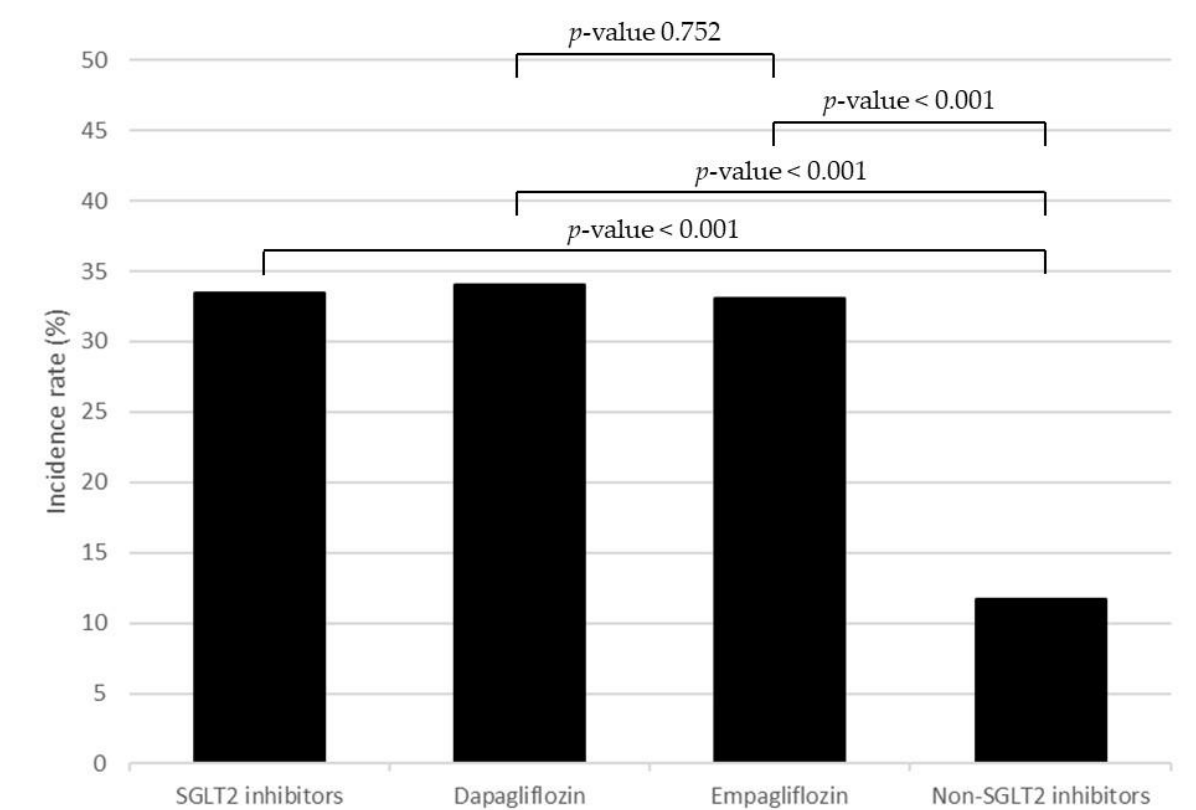
Figure 1. The incidence rate of UTI compared between SGLT2 inhibitors, dapagliflozin, empagliflozin, and non-SGLT2 inhibitors. Table 2. Odds ratios of overall urinary tract infection in patients treated with SGLT2 inhibitors compared with patients treated with non - SGLT2 inhibitors.